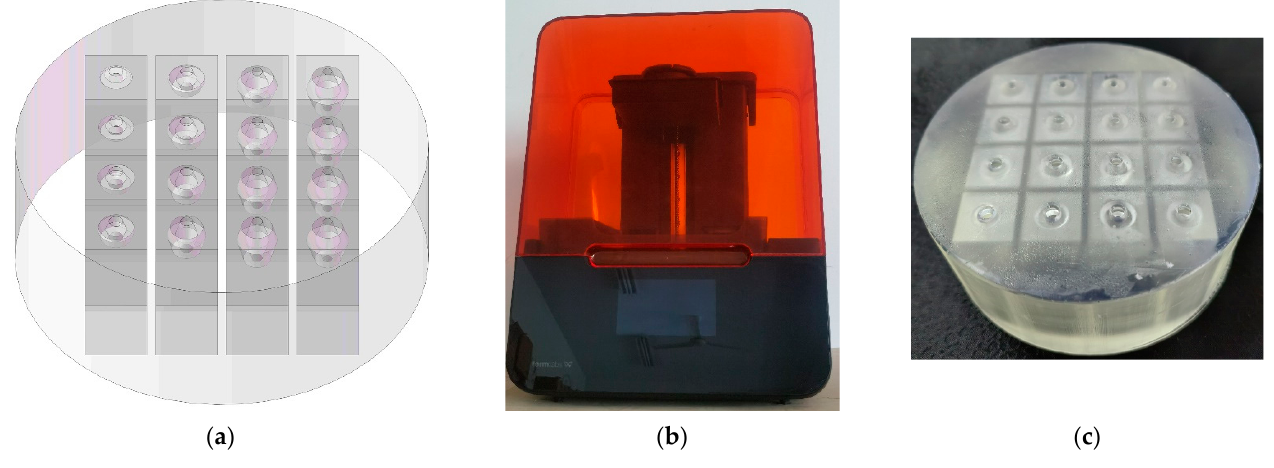
Figure 16. The fabrication of proposed experimental sample. ( a ) The three-dimensional structure of sample; ( b ) the low-force stereolithography 3D printer; and ( c ) the fabricated sample.